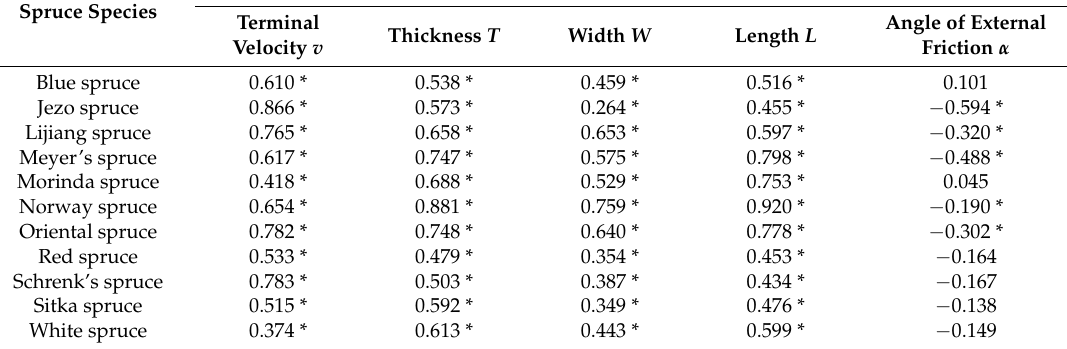
Table 3. Coefficients of linear correlation between mass and the remaining physical properties of spruce